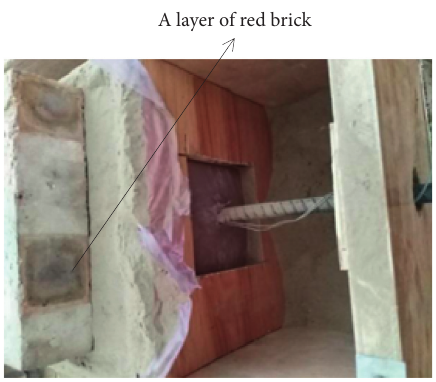
Figure 7: A layer of red brick laid on the upper surface of the model Table 1: The measured test values and calculated value of shear stress (the first test).